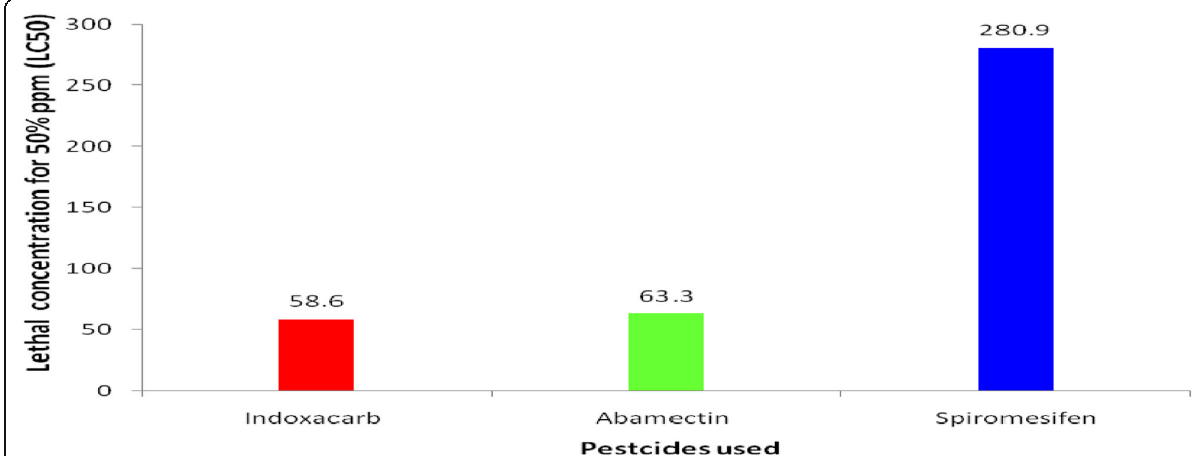
Fig. 1 Effect of the tested pesticides on the adults of chocolate banded snail, Eobania